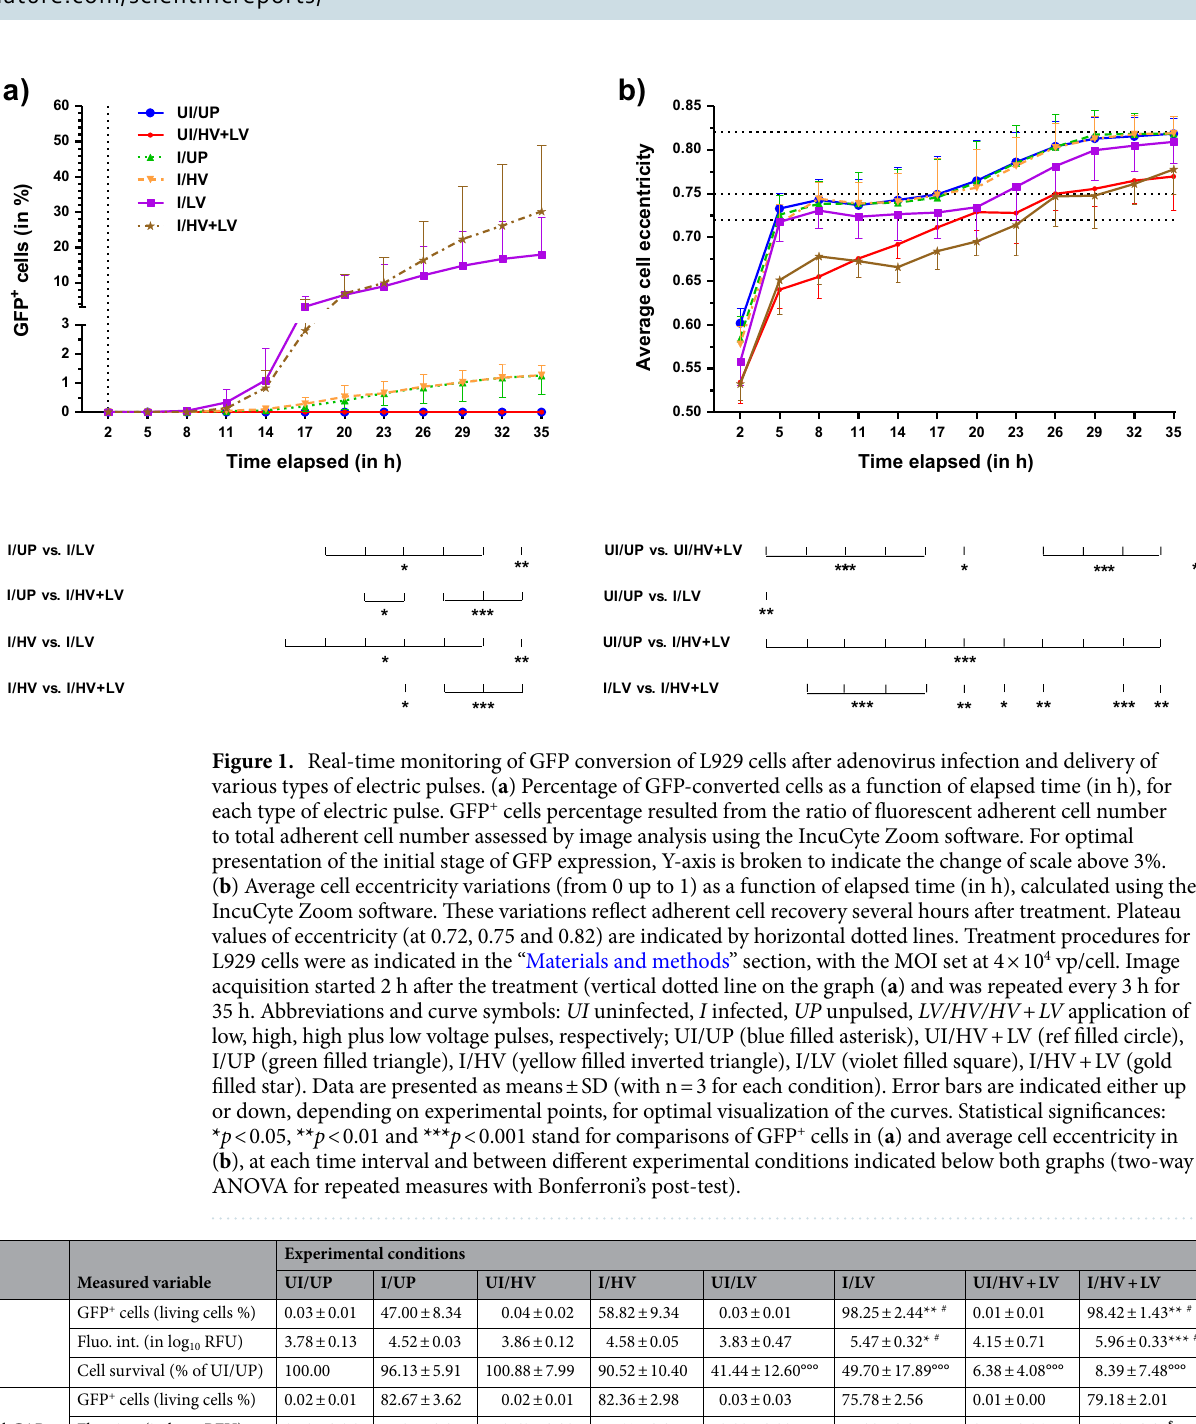
Cell survival (% of UI/UP) 100.00